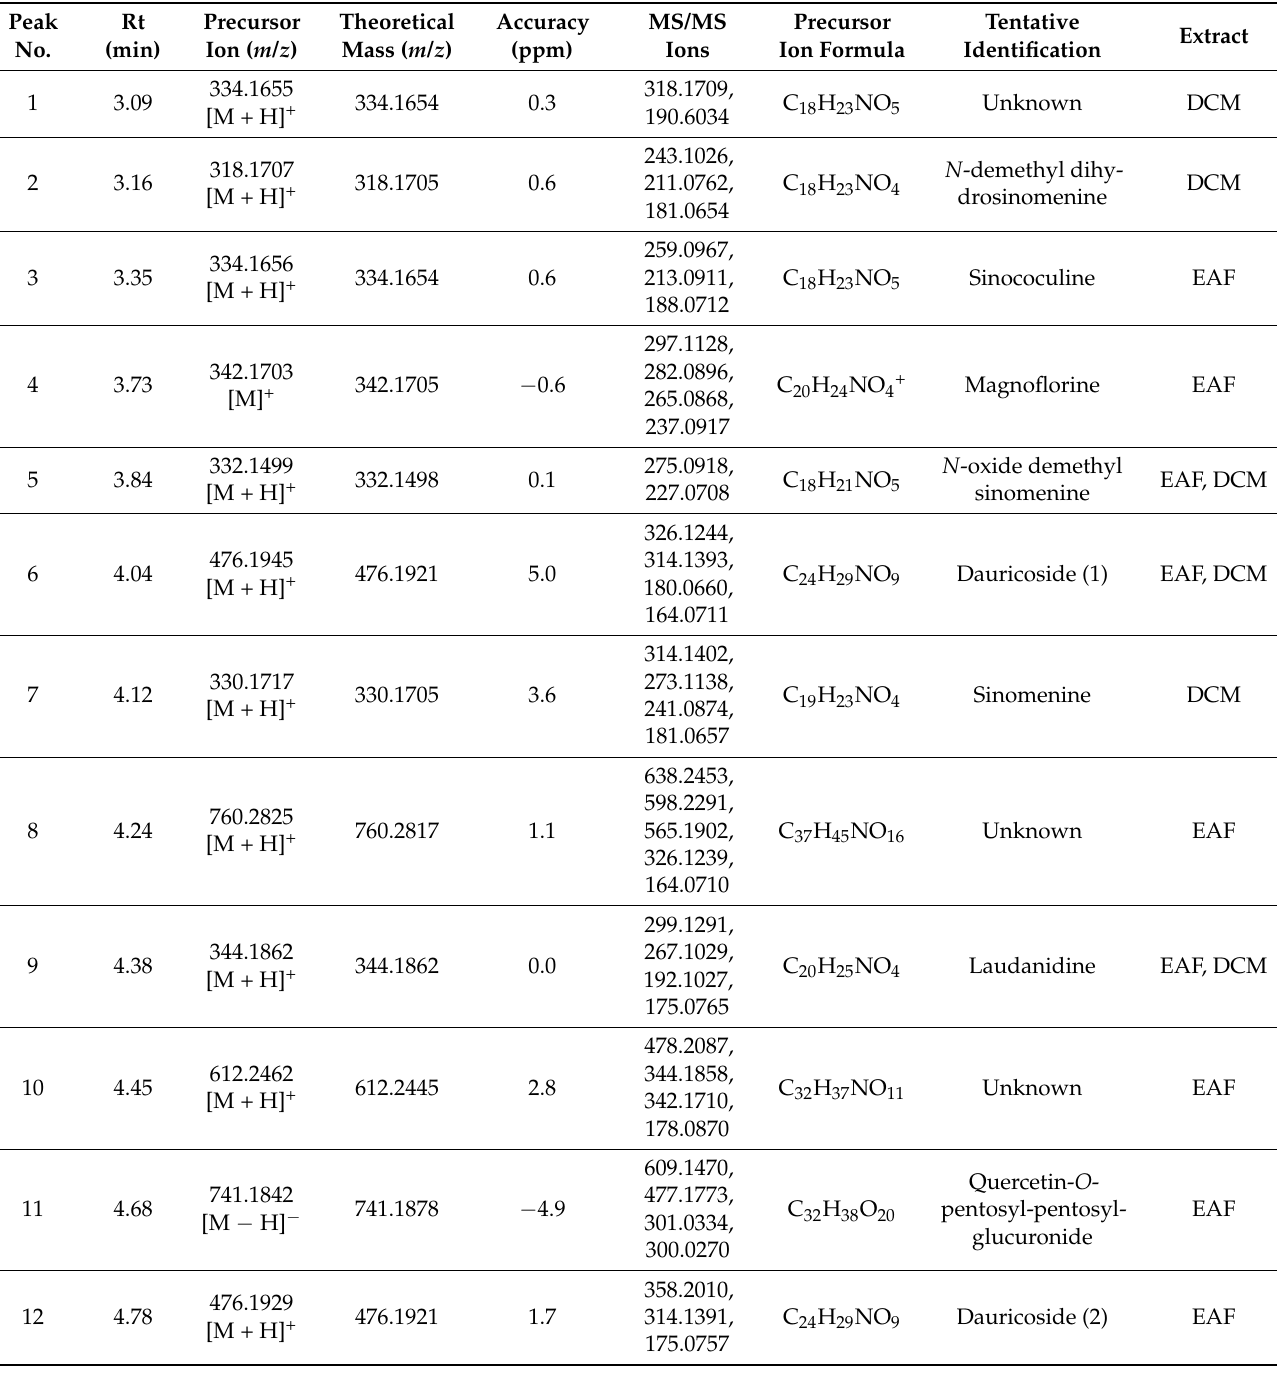
Table 2. Assigned compounds, molecular ions in the ESI ( − ) or ESI (+) modes and fragment ions of the main components present in the dichloromethane (DCM) and ethyl acetate (EAF) fractions of Croton linearis Jacq.